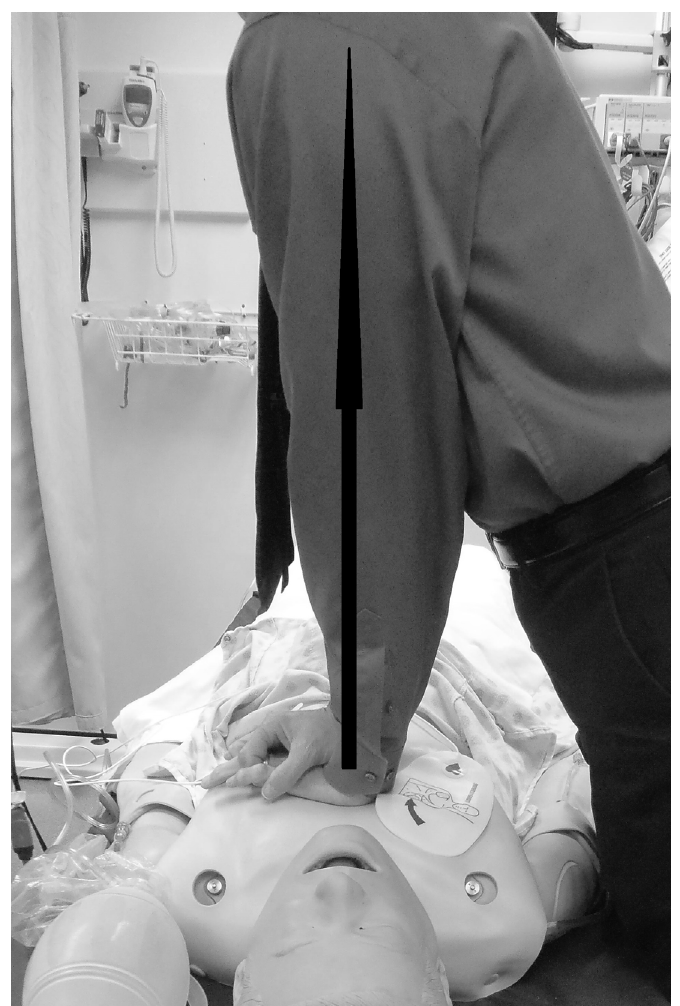
Figure 1. Proper position with the shoulders directly over the point of compression and the rescuer’s arms forming a 90° angle with the patient’s